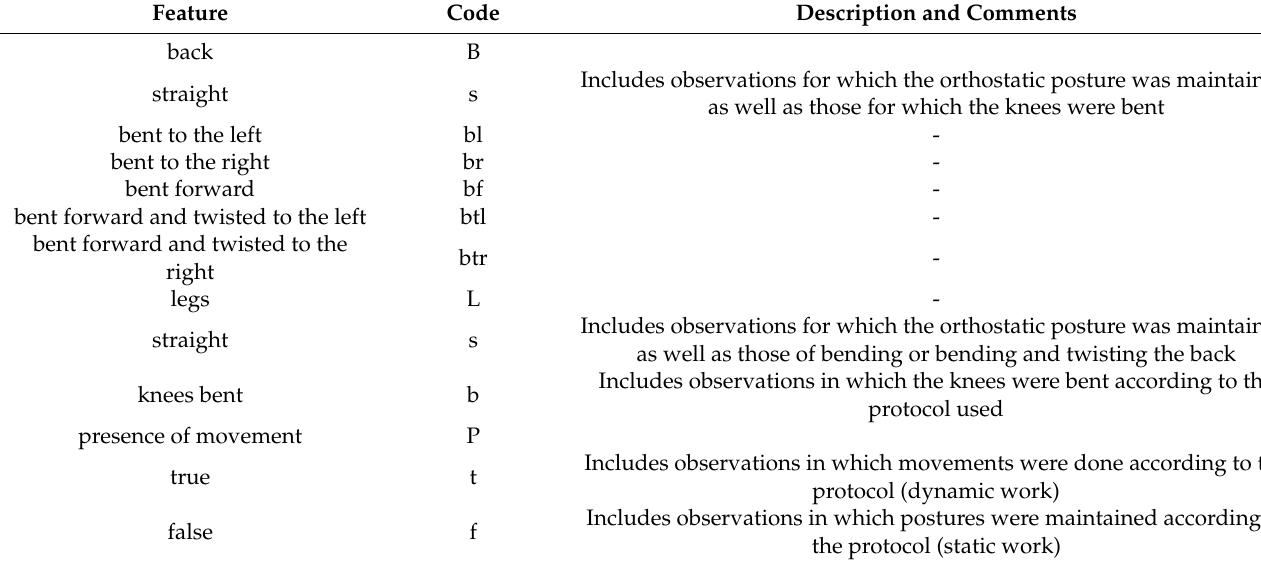
Table 1. Description of the coding protocol used in this